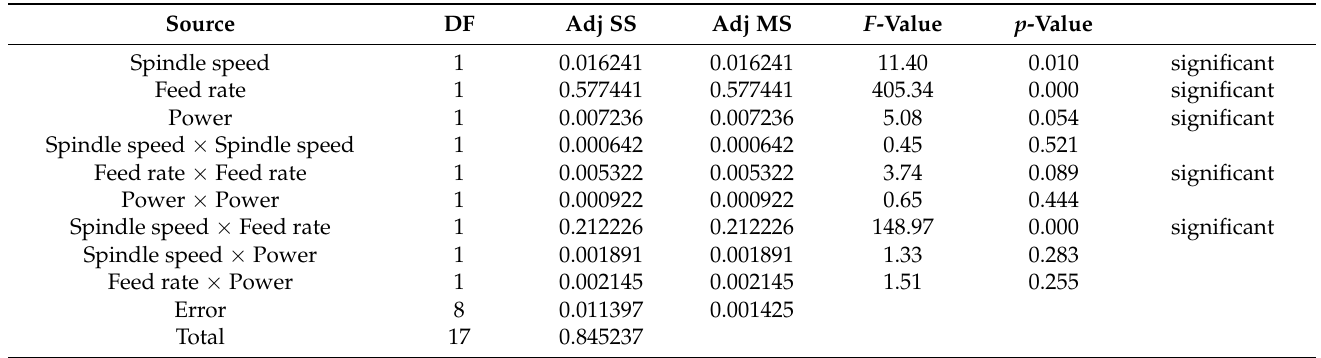
Table 9. ANOVA results for the surface roughness with conventional cutting